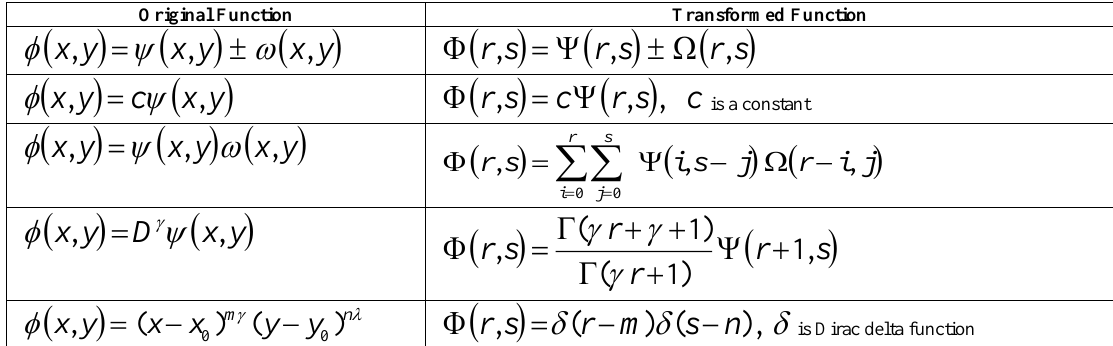
Table 5. Two-dimensional fractional differential